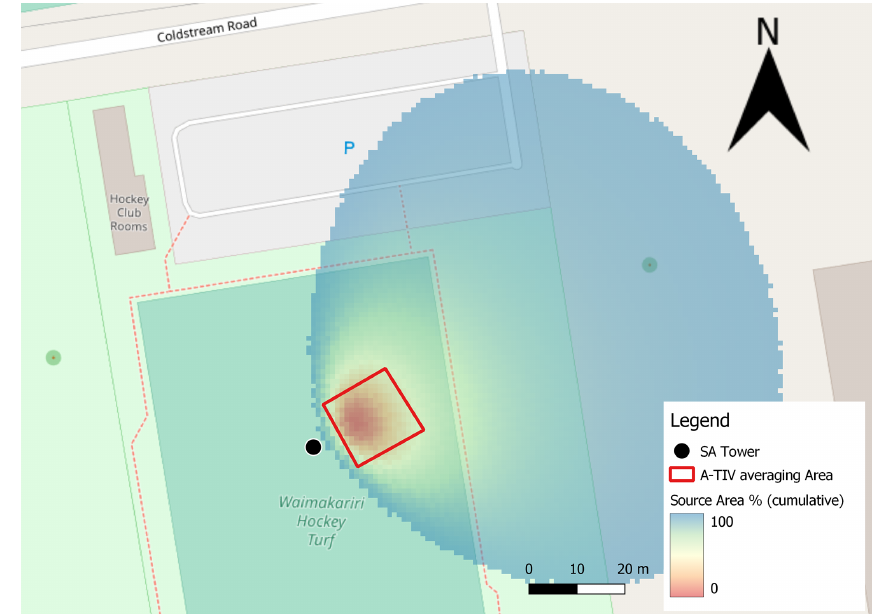
Figure A1. Footprint calculated from the TURF-T1 experiment – background Image: ©OpenStreetMap contributors 2022. Distributed under the Open Data Commons Open Database License (ODbL) v1.0.